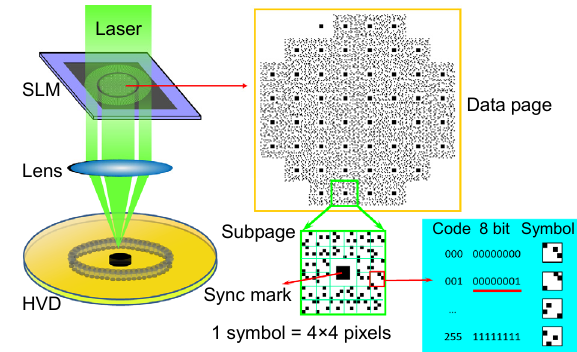
Fig. 4 | Data page format in the